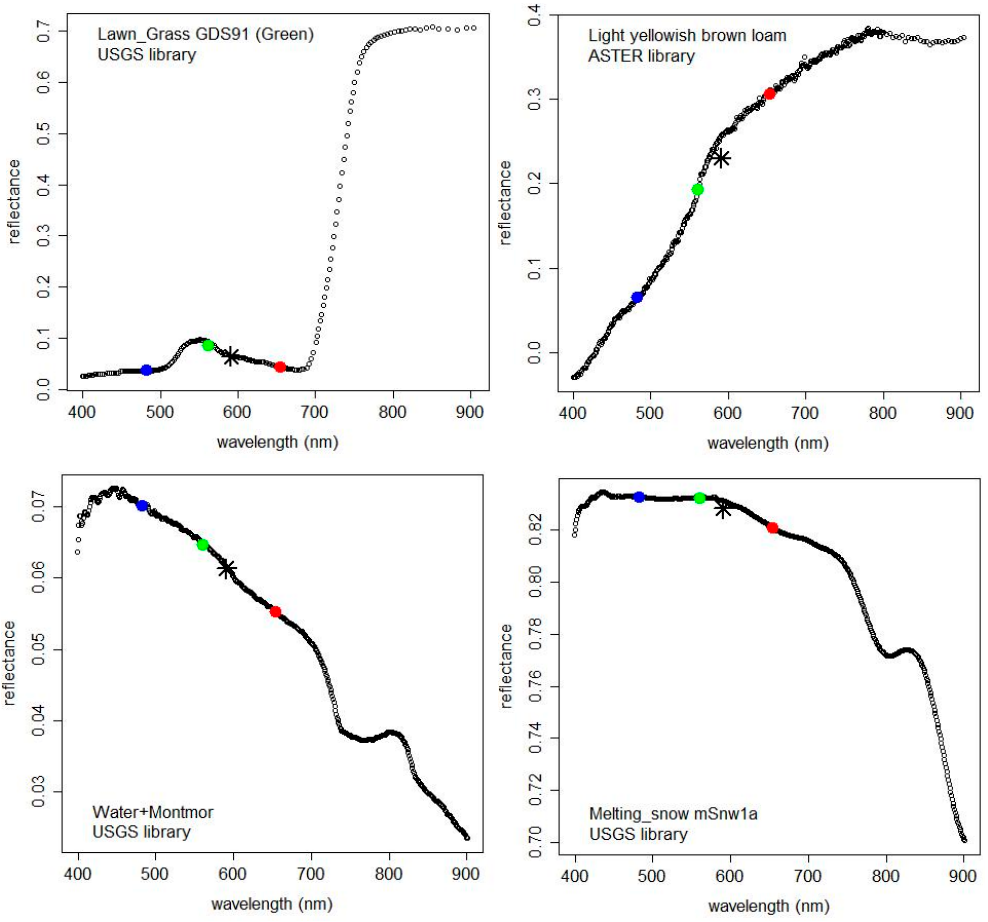
Figure 2. Example vegetation, soil, water and snow spectra and the simulated (see Equation (3)) panchromatic ( black asterisk ), red ( red dot ), green ( green dot ), and blue ( blue dot ) Landsat 8 Operational Land Imager (OLI) reflectance plotted at the Landsat 8 band center wavelengths.